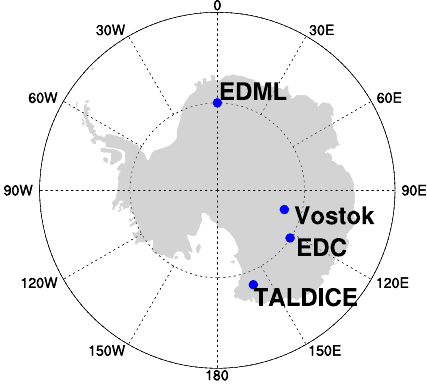
Figure 6. Locations of the ice core sites in